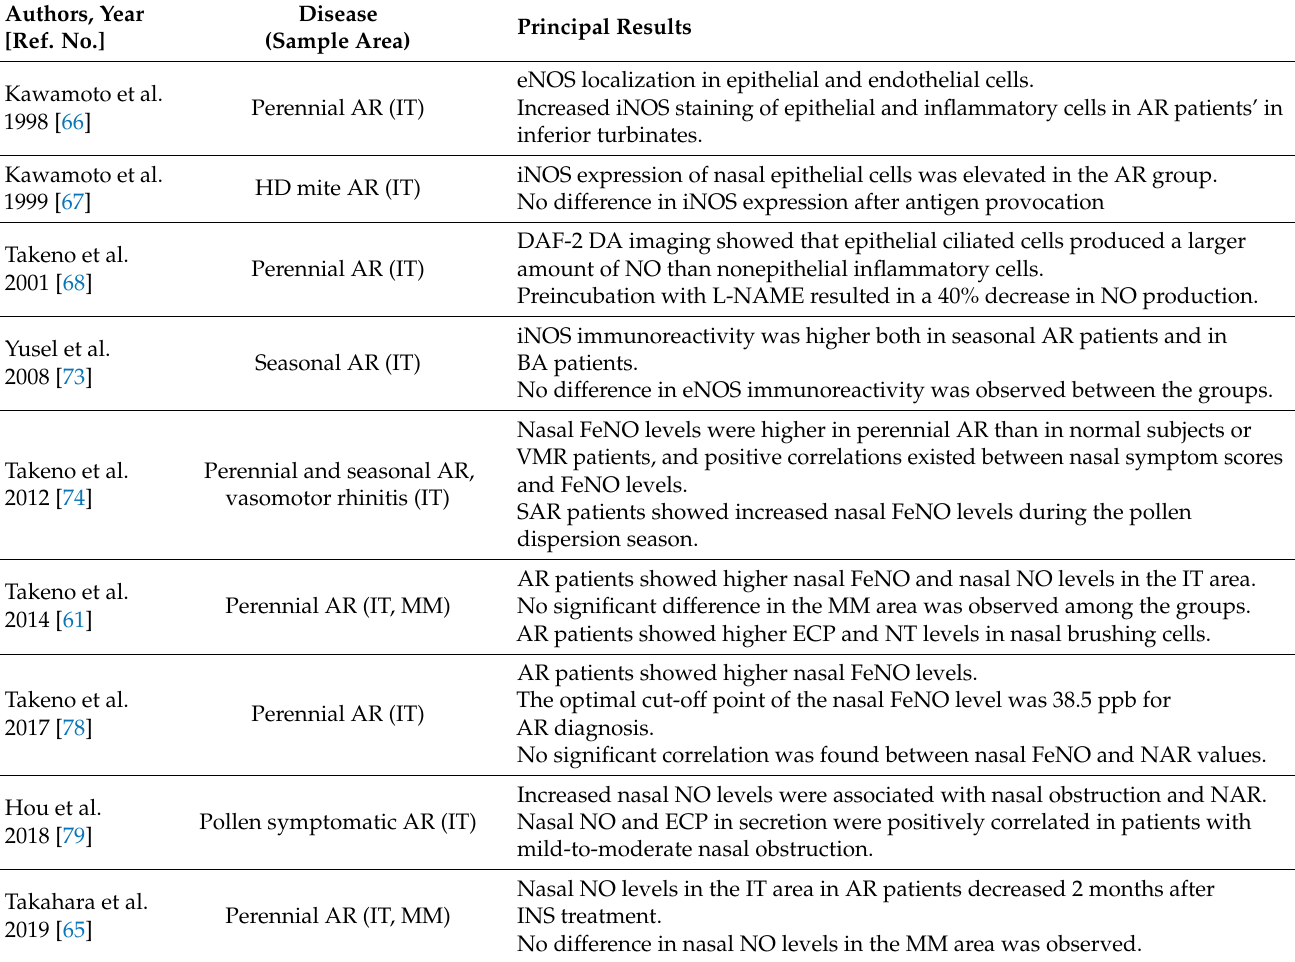
Table 1. Studies focusing on the expression and distribution of NOS isoforms and concomitant NO production in allergic rhinitis